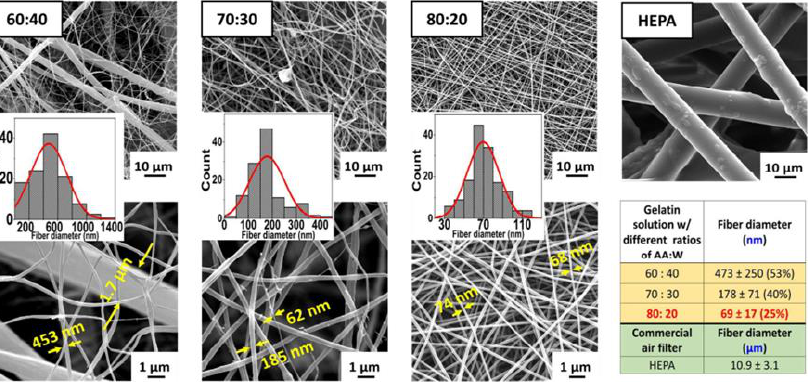
Figure 6. Scanning electron microscopy (SEM) images of gelatin fibers produced with different rations of Acetic Acid-to-water on fibers’ morphology and their filtration capacity, compared to commercial HEPA filter. Reproduced with permission from [90].